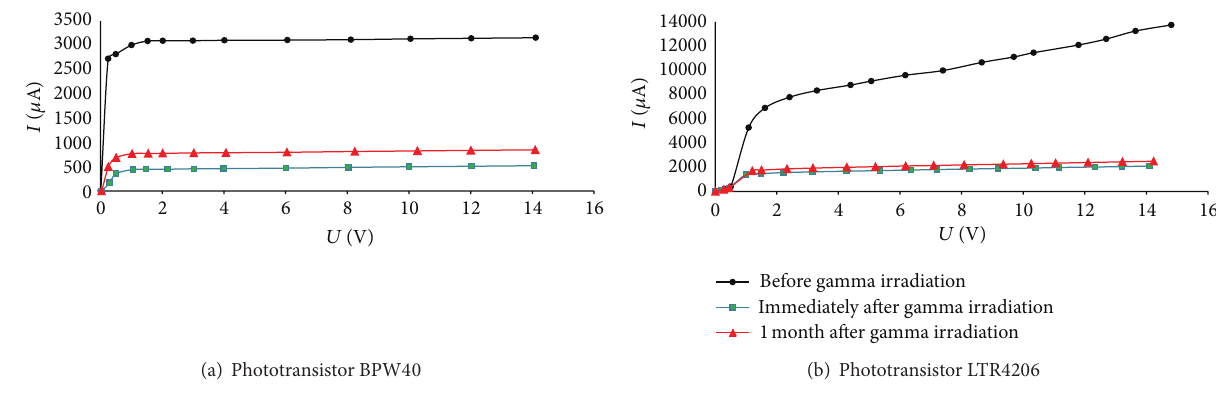
Figure 1: I - V characteristics of the phototransistors before and after gamma irradiation.